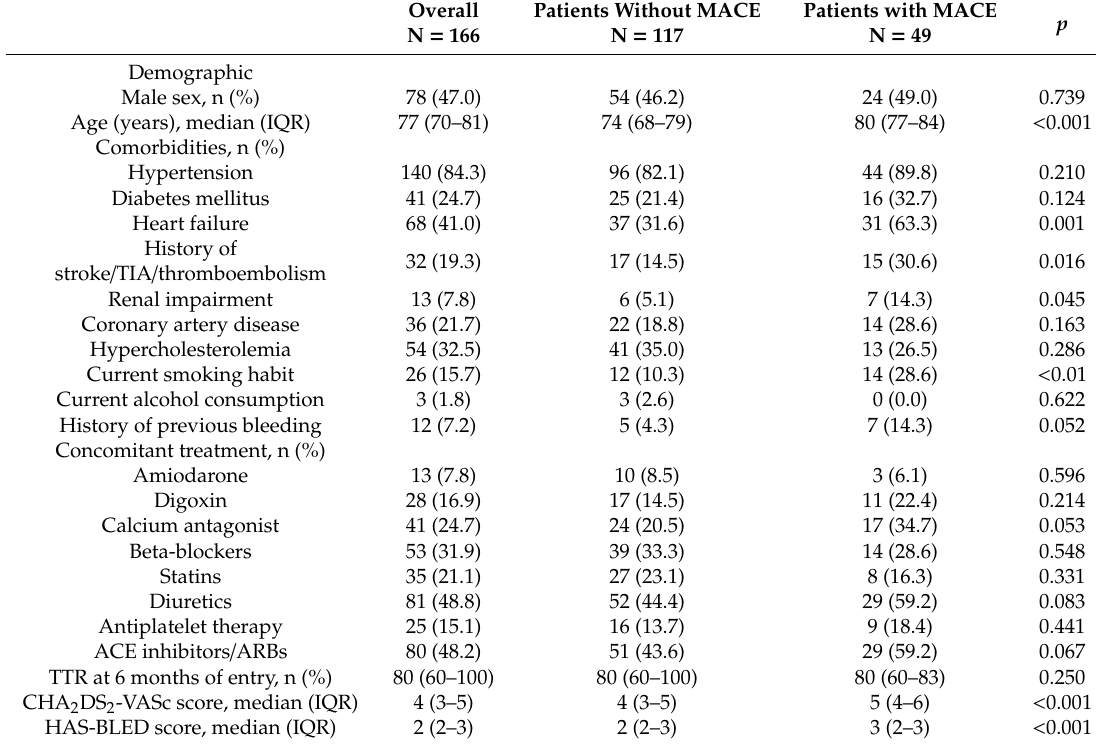
Table 1. Validation study cohort baseline clinical characteristics.